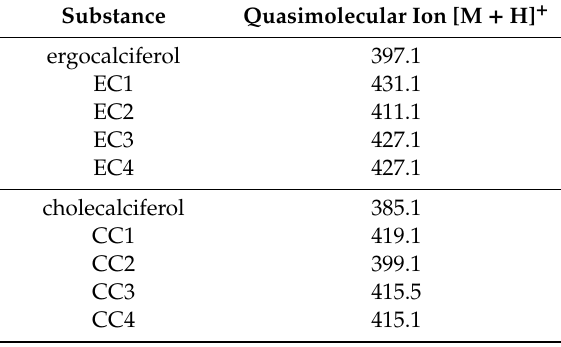
Table 1. Summary of quasimolecular ions of detected oxidation products EC1–EC4 and